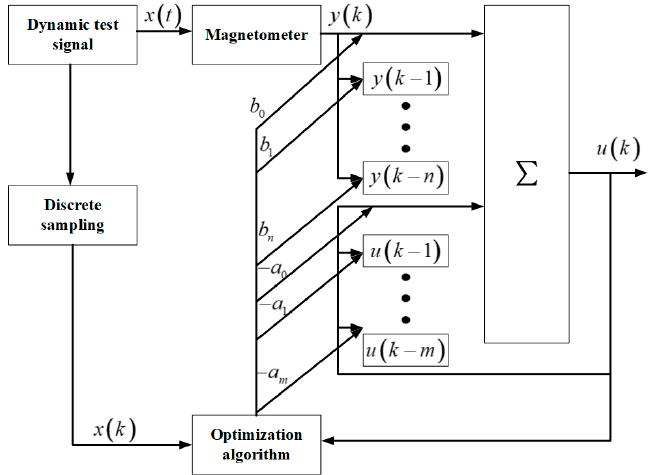
Figure 8. Block diagram of the dynamic compensator.